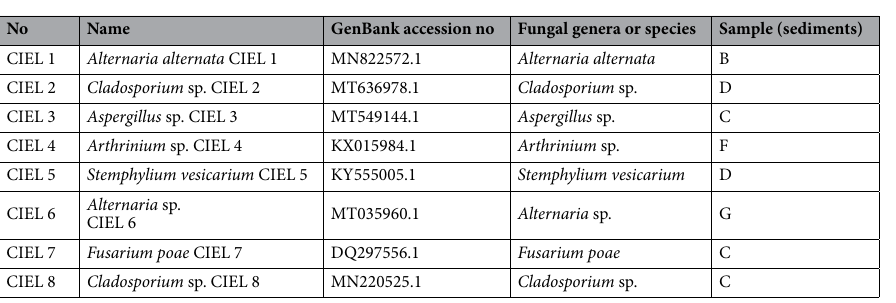
Table 3. Species information for hadal-derived fungi isolated and cultured in this